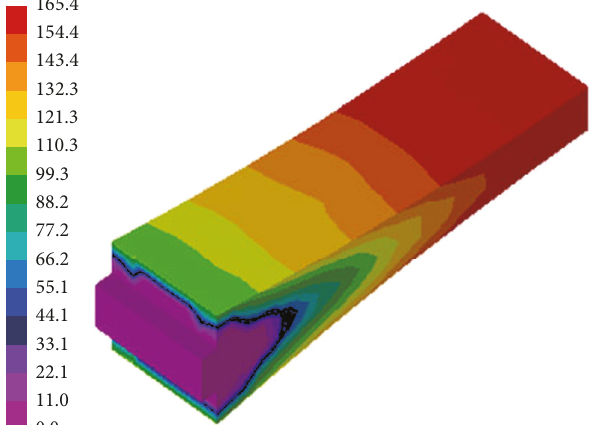
Figure 7: Simulation results of the yield strength of Al-10Mg alloy plate.